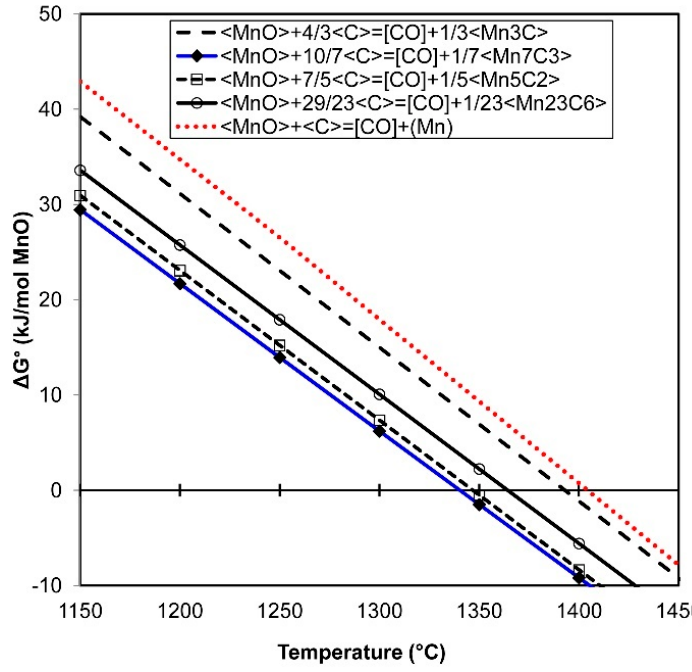
Figure 1. Gibbs energy in carbothermic reduction of MnO.